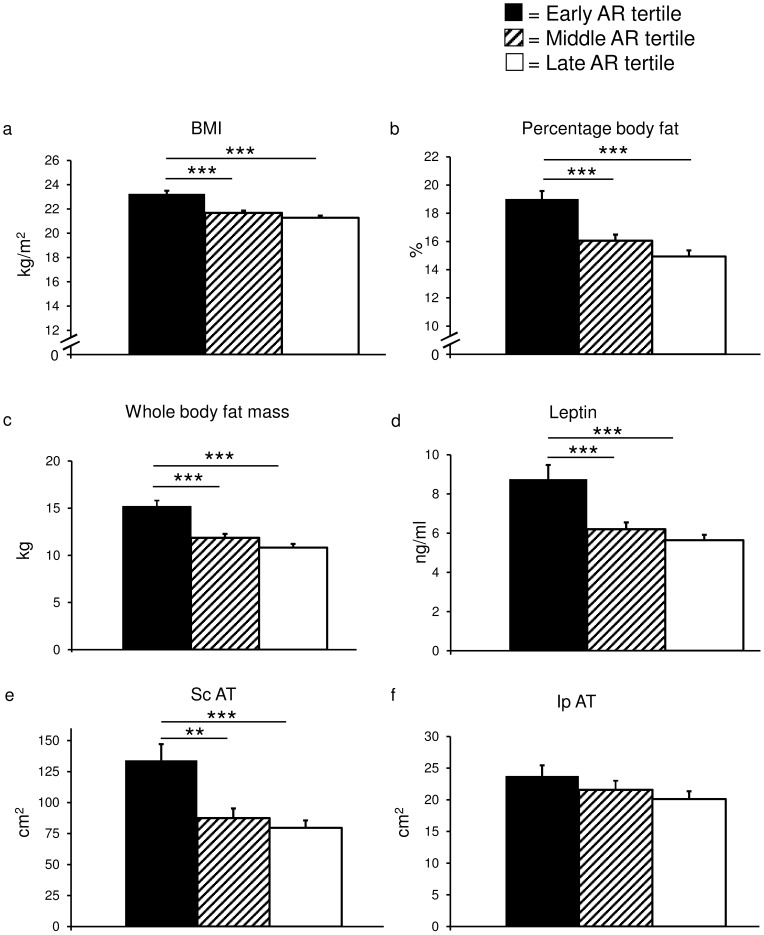
Fat parameters according to age at AR tertiles.Histograms representing early, middle and late age at adiposity rebound tertiles for BMI (a), percentage body fat (b), whole body fat mass (c), serum leptin levels (d), Subcutaneous adipose tissue (ScAT; n = 194; e) and Intraperitoneal adipose tissue (IpAT; n = 194; f). Values are given as means ± SEM. BMI = Body Mass Index, **p<0.01, ***p<0.001.